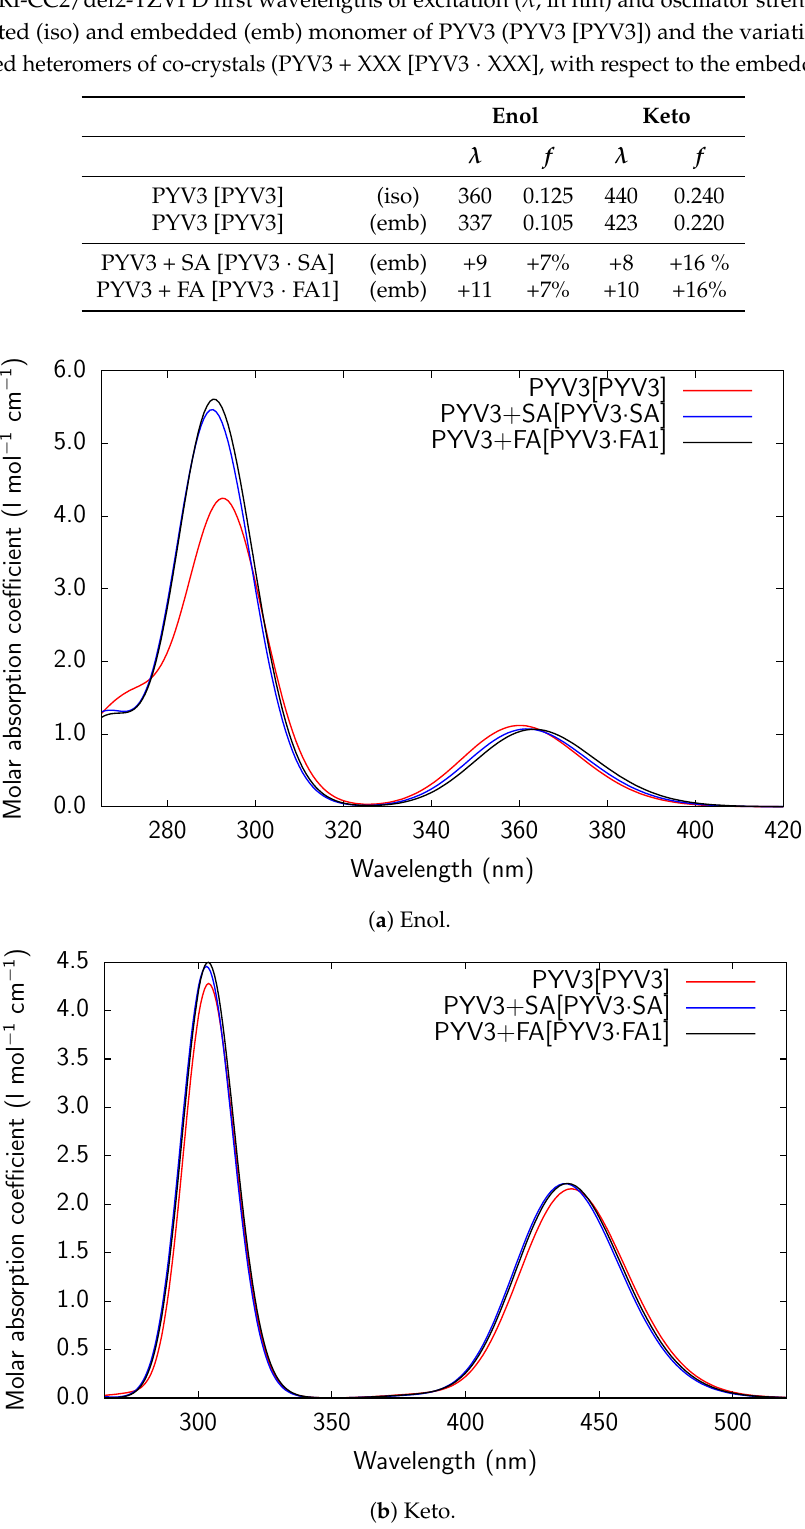
Figure 4. RI-CC2/def2-TZVPD UV/Vis absorption spectra of the isolated PYV3 [PYV3] and of the isolated heteromers of PYV3 · SA and PYV3 · FA1 co-crystals (PYV3 + SA [PYV3 · SA] and PYV3 + FA [PYV3 ·